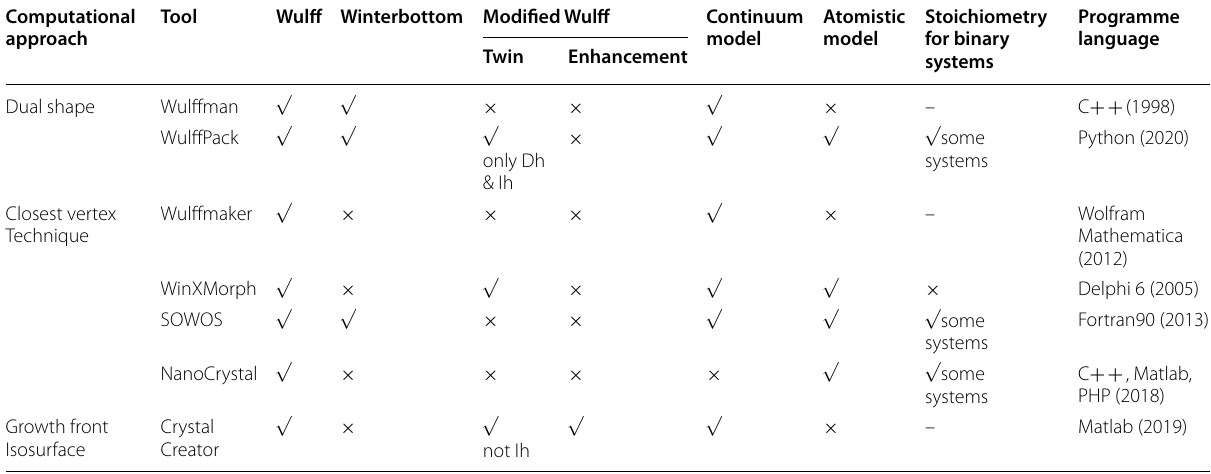
Table 1 Summary of the main Wulff-modelling software and their shape construction capabilities Computational